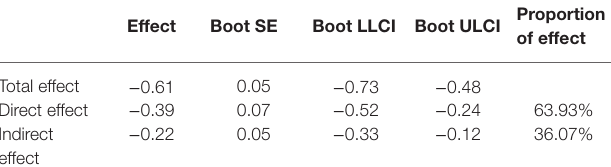
TABLE 5 | Total effect, direct effect, and indirect effect in study model.